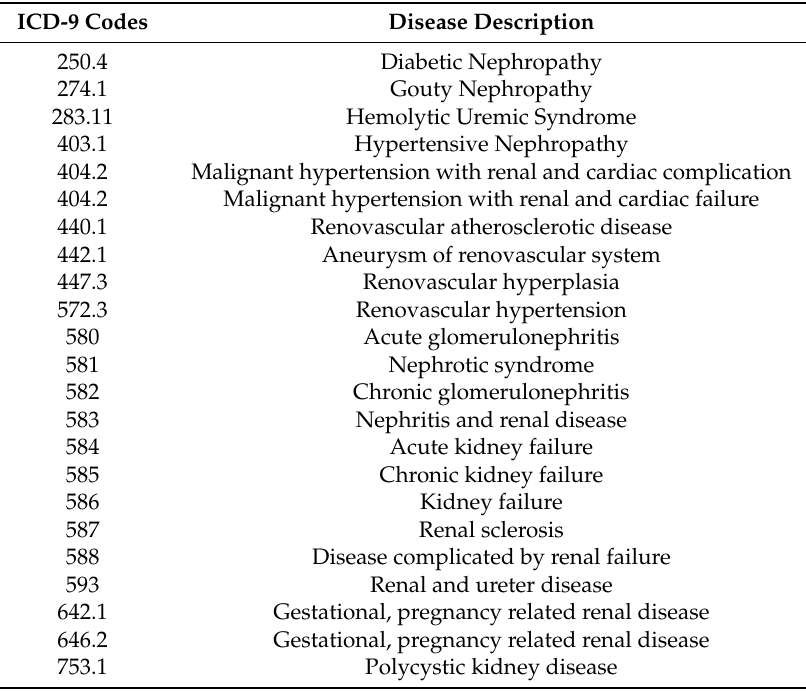
Table A2. Description of ICD-9